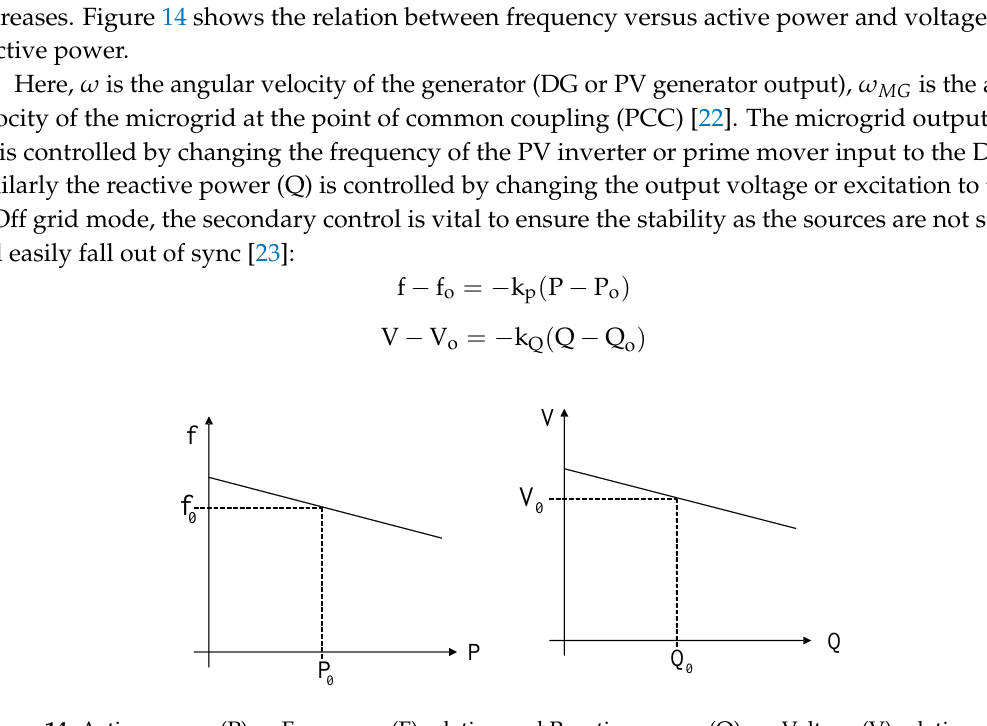
Figure 14. Active power (P) vs Frequency (F) relation and Reactive power (Q) vs. Voltage (V) relation at PCC.